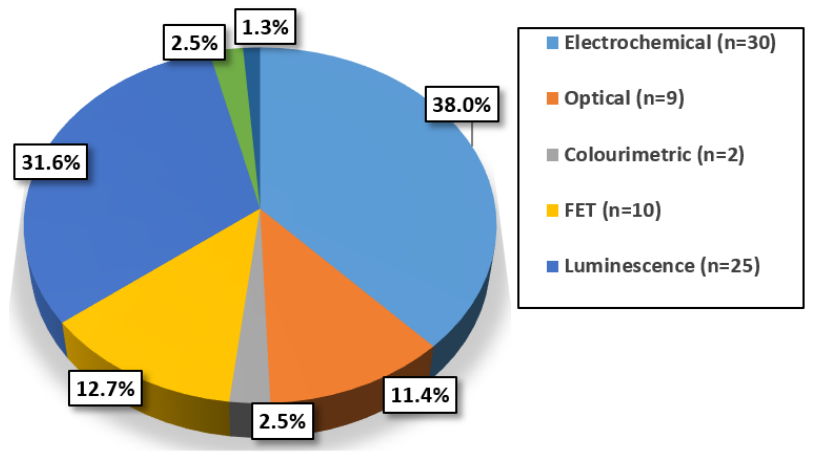
Figure 3. Means of detection employed by researchers for cTnI since 2015. Data was collected for cTnI detection from 77 journal papers reviewed and each technique was appropriately classified based on the assay and biosensor detection mechanism utilised. Two papers have presented two different techniques, one of these being a qualitative colourimetric lateral flow assay [37,38,48– 50,57,58,61,65,66,68–71,74,84–89,93–97,104,105,111,112,115–117,120–123,125–128,130,132–134,136,138,144,145, 148,150,151,159,161,174–176,184–202] .